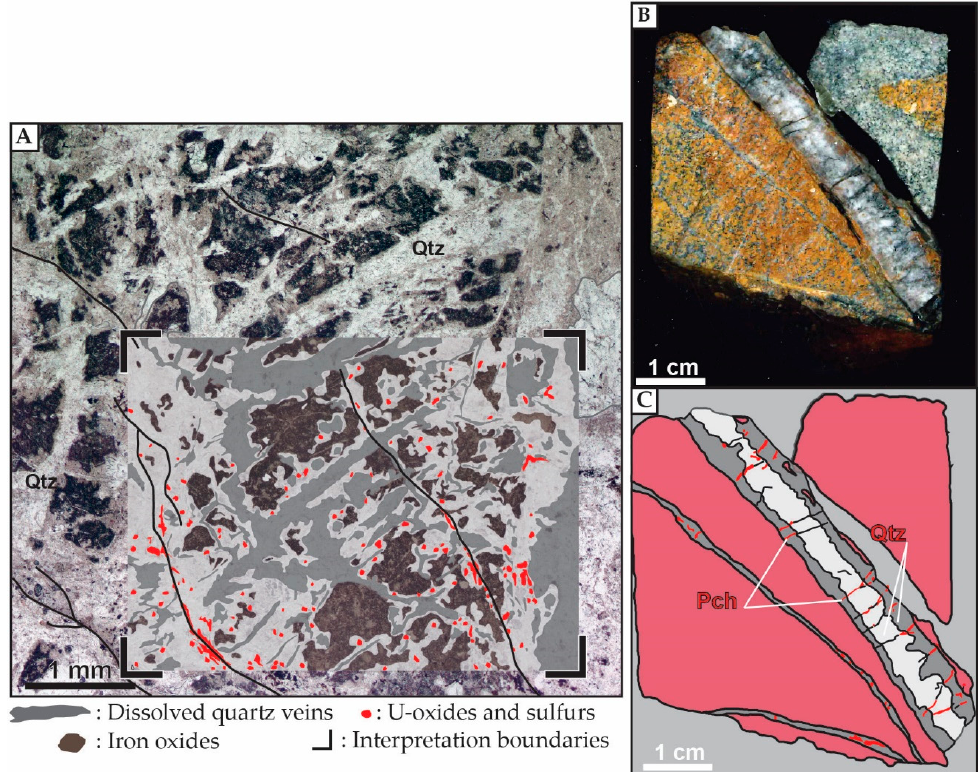
Figure 13. ( A ) Plane polarized light picture and interpretation drawing of a quartz vein network guiding the mineralizing fluid along its boundaries. Quartz and iron oxides display evidence for dissolution; ( B , C ) macroscopic drill core sample scan and interpretation drawing: Examples of a QB related quartz vein bearing pitchblende (Pch) along edges or in orthogonal microfractures.